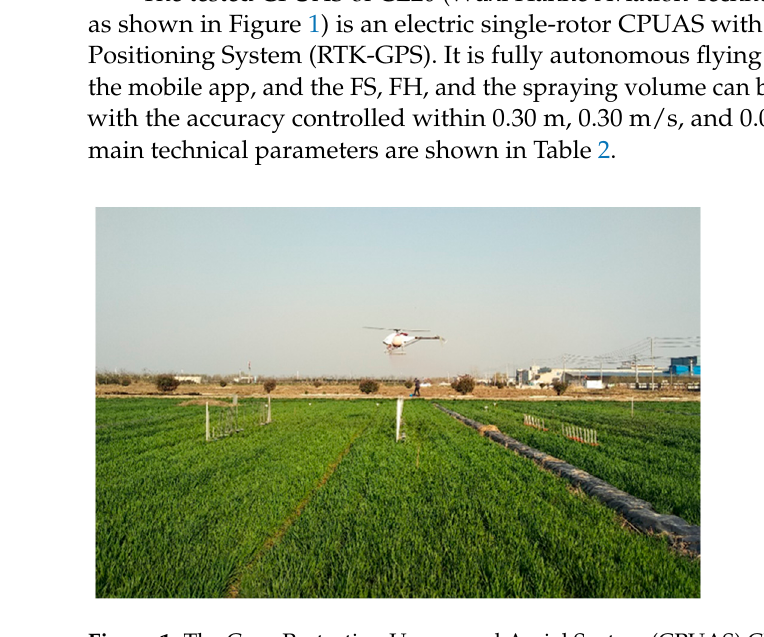
Figure 1. The Crop Protection Unmanned Aerial System (CPUAS) CE20. Table 2. The main technical parameters of CE20. Items